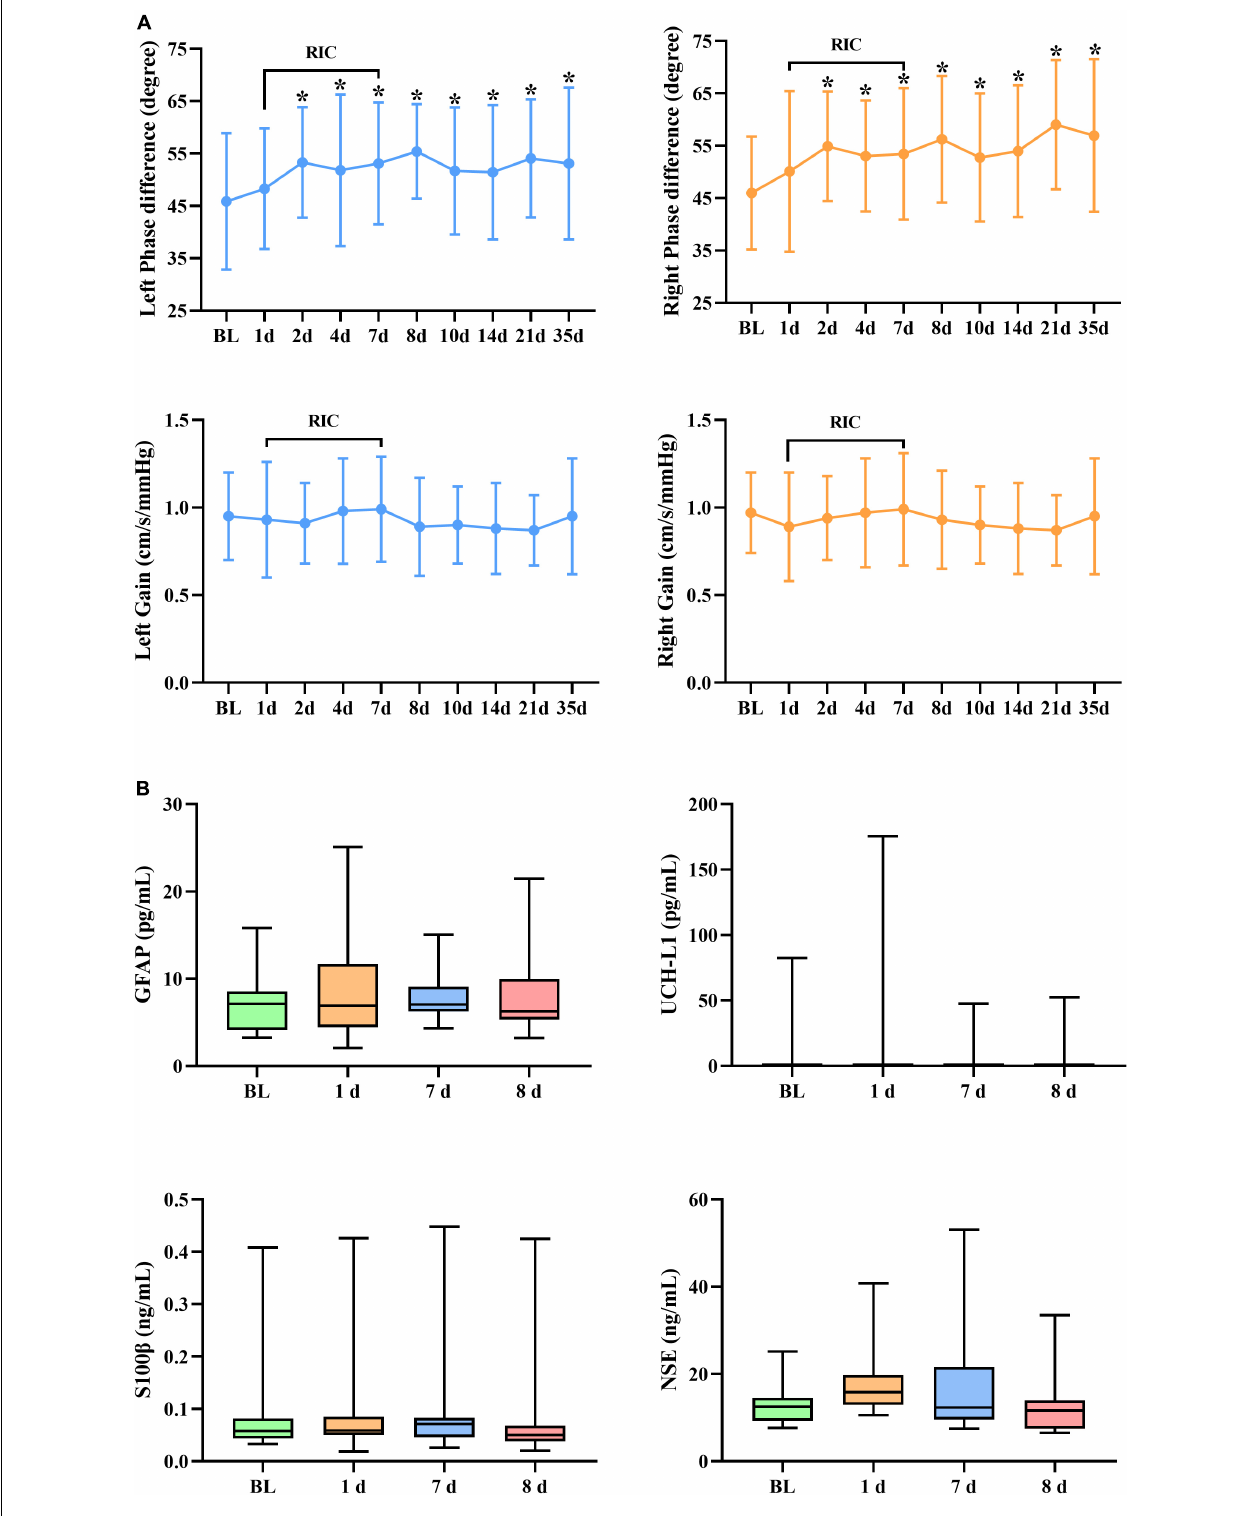
FIGURE 2 | (A) Dynamic cerebral autoregulation (dCA) parameters and (B) serum biomarkers during and after RIC. RIC, remote ischemic conditioning; dCA, dynamic cerebral autoregulation; GFAP, glial fibrillary acidic protein; UCH-L1, ubiquitin C-terminal hydrolase-L1; and NSE, neuron-specific enolase. * p < 0.05 compared with